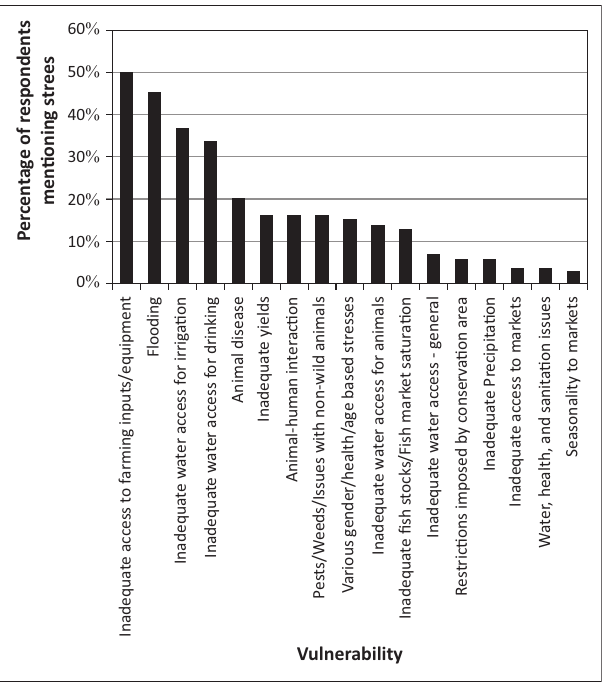
FIGURE 4: The overall vulnerability context of Kasaya, as reported by residents of the community.